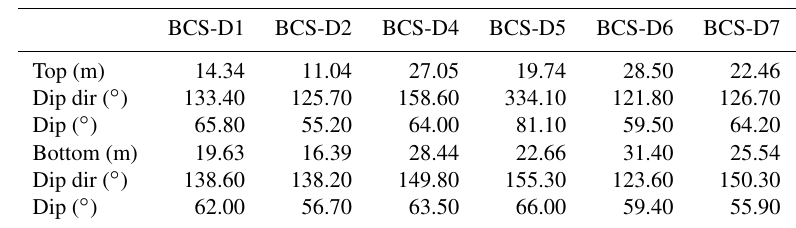
Table 2. Main fault geometry. Top: top of the main fault (middle point), bottom: bottom of the main fault (middle point), dip dir: direction from true north; due to poor image log quality in BCS-D3, no orientation could be identified.